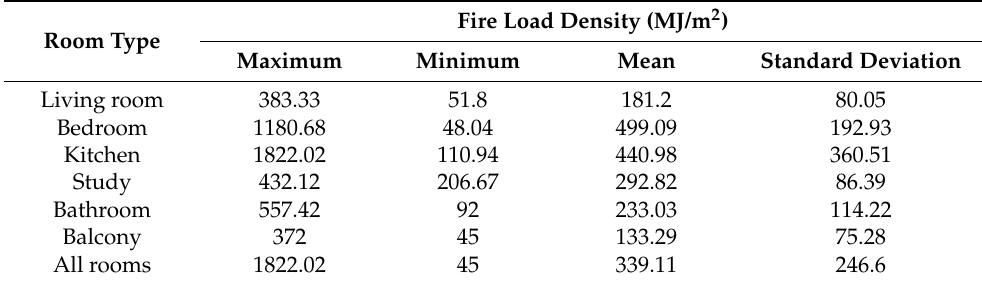
Table 2. Statistics of fire load density for different types of